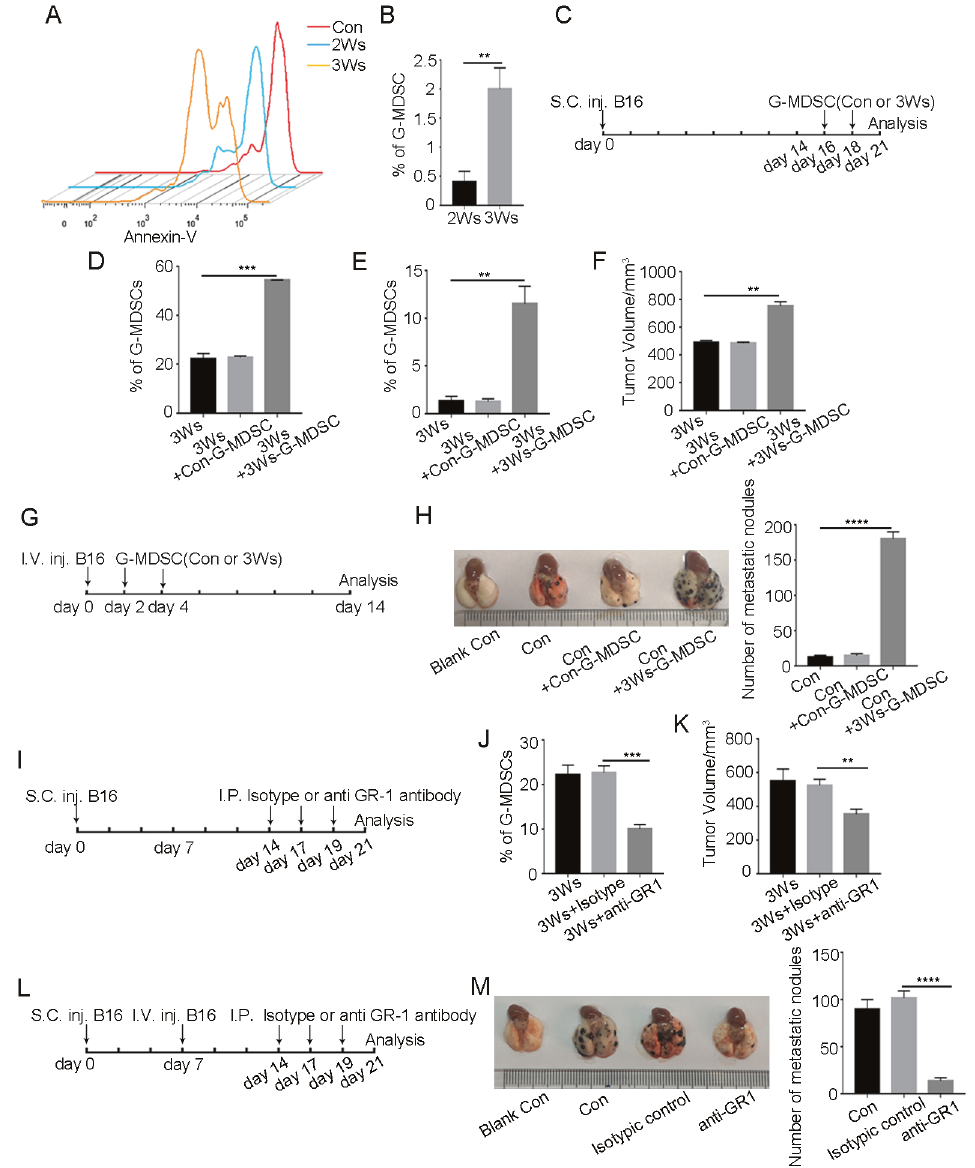
Fig. 2 G-MDSCs with immunosuppressive functions promote tumor growth and metastasis. A Annexin-V expression in G-MDSCs in peripheral blood taken from mice after different durations of tumor bearing was assessed by FCM. B The proportion of G-MDSCs in tumor tissue taken from mice bearing tumors for 2 or 3 weeks was analyzed by FCM ( n = 3). C , G Schematic depiction of the experimental protocol for infusion of mice with either G-MDSCs from the peripheral blood of normal mice (Con-G-MDSCs) or G-MDSCs from mice bearing tumors for 3 weeks (3Ws-G-MDSCs). Tumor-bearing mice were infused with either Con-G-MDSCs or 3Ws-G-MDSCs at the indicated time, and the proportions of G-MDSCs in peripheral blood ( D ) and tumor tissue ( E ) were analyzed by FCM ( n = 4). F Tumor volume was measured after the tumor-bearing mice received either Con-G-MDSCs or 3Ws-G-MDSCs at the indicated time ( n = 4). H The number of metastatic foci was detected after intravenous injection of B16F10 cells and infused with either Con-G-MDSCs or 3Ws-G-MDSCs ( n = 4). I , L Schematic depiction of the experimental design. B16F10 cells were injected into mice through the tail vein, and the mice were treated with an anti-GR1 antibody (200 μ g/I.P.) every 3 days. On day 21, lung metastasis was analyzed. J The proportion of G-MDSCs in peripheral blood was detected after anti- GR1 antibody treatment ( n = 3). K Tumor volume was measured after anti-GR1 antibody treatment ( n = 4). M The number of metastatic foci was detected after anti-GR1 antibody treatment ( n = 4). Results are mean ± SD. Unpaired t- test was used to determine signi fi cance (** p < 0.01, *** p < 0.001 and **** p < 0.0001). (Fig. 5G). The effect of rapamycin on G-CSF-stimulated G-MDSCs was (shRNAs) to stably decrease G-CSF levels (Fig. 5D and Supple- next investigated, and the results showed that after treatment with mentary Fig. 5F). After shRNA transfection in vivo, we observed a rapamycin, Stat3 phosphorylation decreased and Arg1 expression decrease in the number of G-MDSCs and a decrease in the was decreased (Fig. 5H, I). Consistent with previous reports expression of Arg1 (Fig. 5E, F and Supplementary Fig. 5G). [34, 38, 39], stattic treatment reduced the expression of Arg1 Next, the effect of G-CSF on the PI3K-Akt/mTOR pathway was (Fig. 5J, K). These results suggest that G-CSF promotes G-MDSCs examined. After treatment of bone marrow G-MDSCs with G-CSF immunosuppressive functions through PI3K-Akt/mTOR pathway. in vitro, PI3K-Akt/mTOR pathway-related proteins were activated